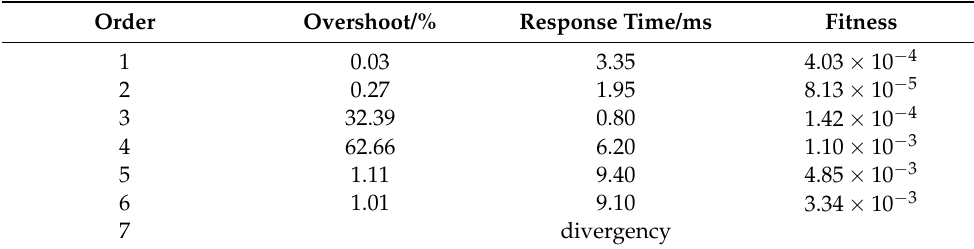
Table 2. Dynamic compensator’s performance for different